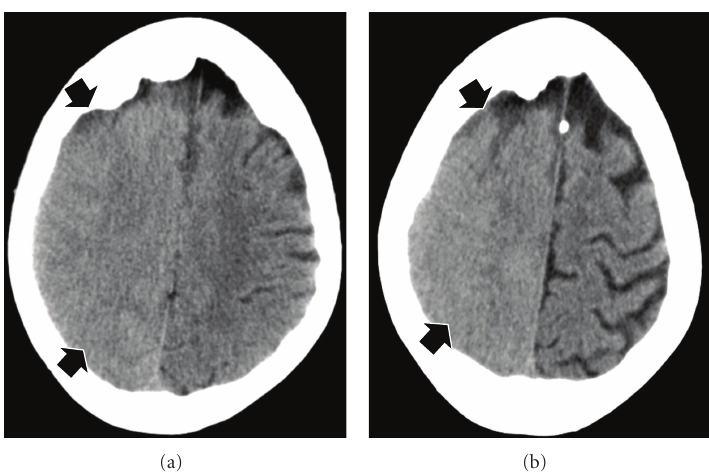
Figure 1: Unenhanced computed tomography obtained one hour after the onset of patient’s symptoms ((a) and (b)) showed sulcal e ff acement in the right cerebral hemisphere due to cerebral swelling. The changes were most marked in the high frontal and parietal lobes.